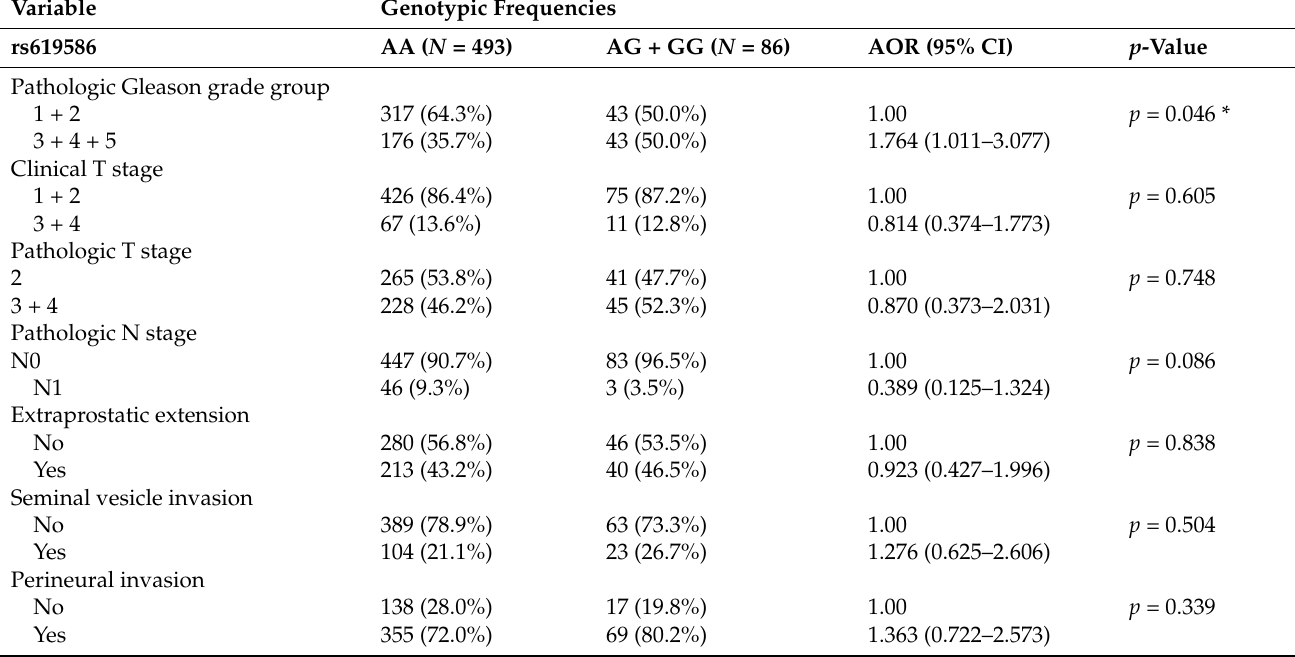
Table 3. Odds ratio (OR) and 95% confidence interval (CI) of clinical status and MALAT1 rs619586 genotypic frequencies in 579 patients with prostate